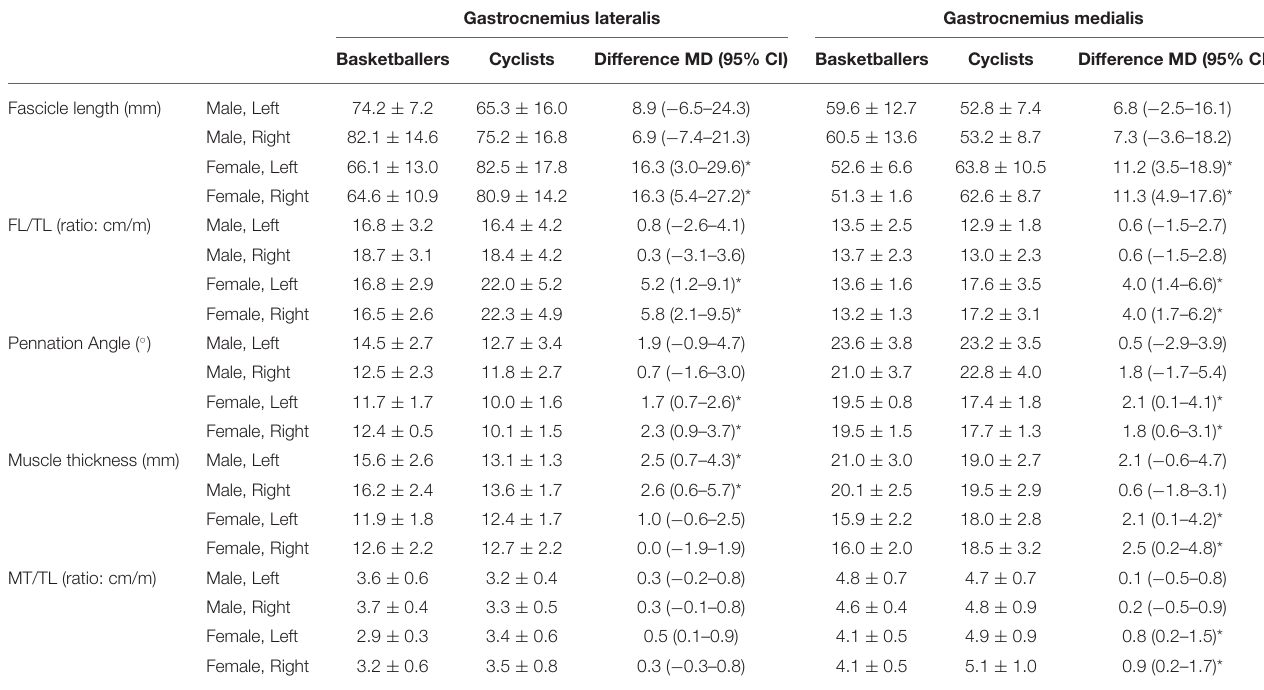
TABLE 2 | Summary of gastrocnemius architectural data in basketballers and cyclists (mean ±